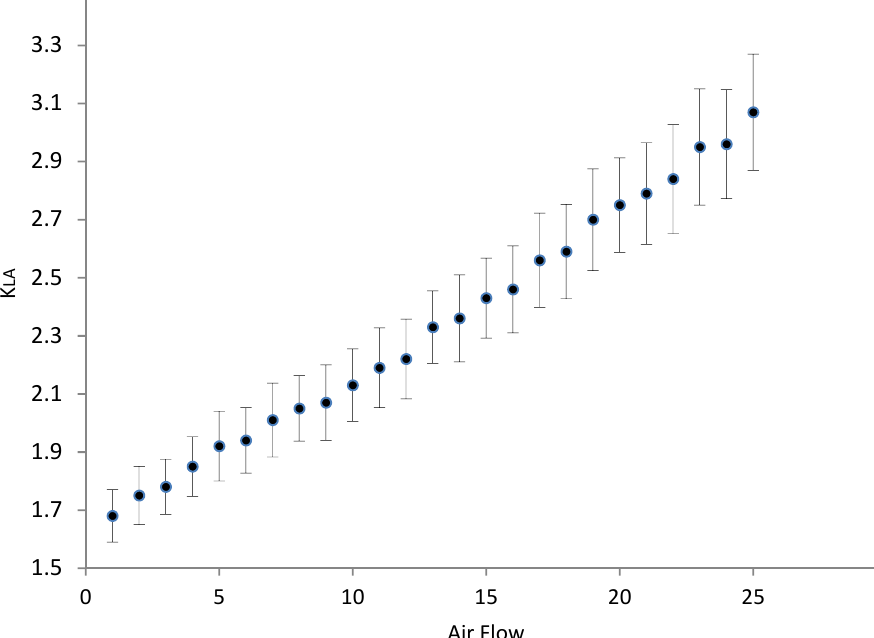
Figure 7. The oxygen global transfer coefficient K La (s − 1 ) values (normalized at 20 °C) in the ordinate vs. air flow (L min − 1 ) in the abscissa. The ordinate values were multiplied by 10 4 .